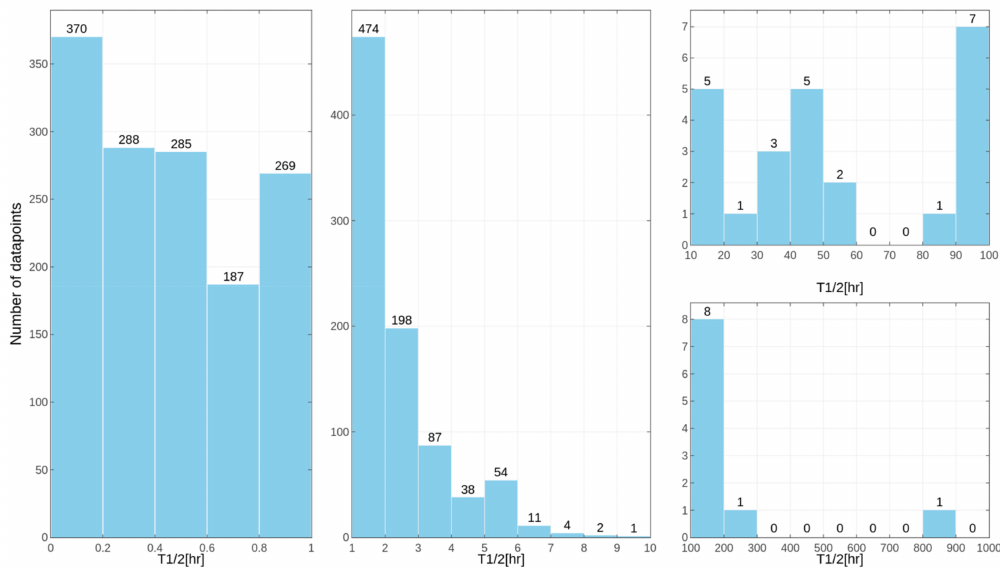
Figure 1. Distribution of compound half-lifetimes in the constructed datasets referring to experiments performed on human samples. For better visualization, the dataset was divided into several